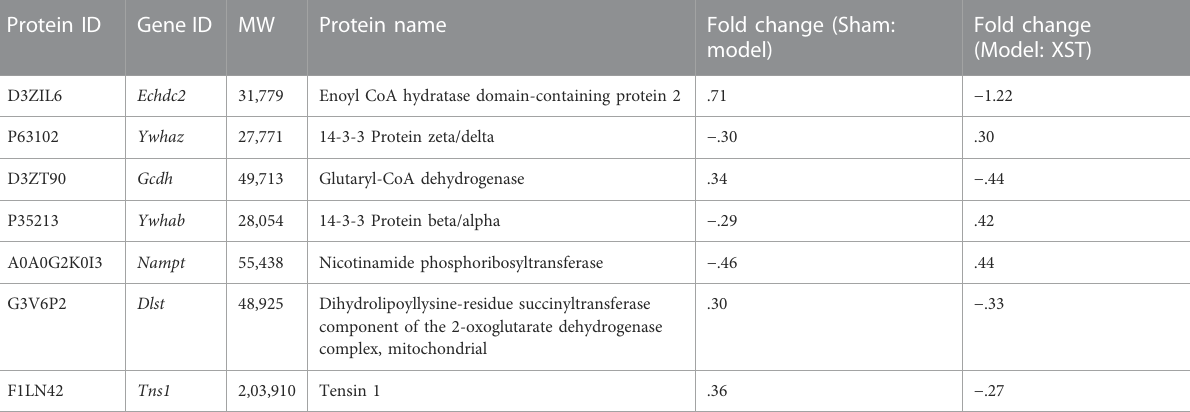
TABLE 1 Critically shared DEPs in the Sham: model and Model: XST comparisons. Protein ID